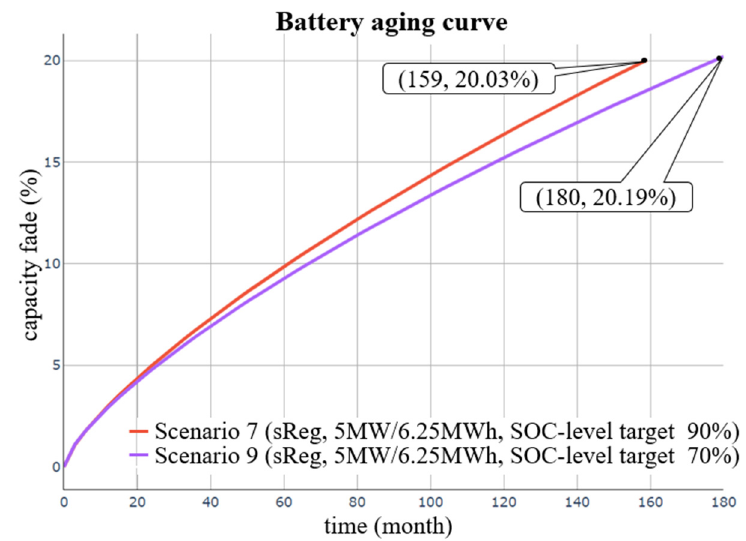
Figure 20. The result under different SOC levels (sReg).